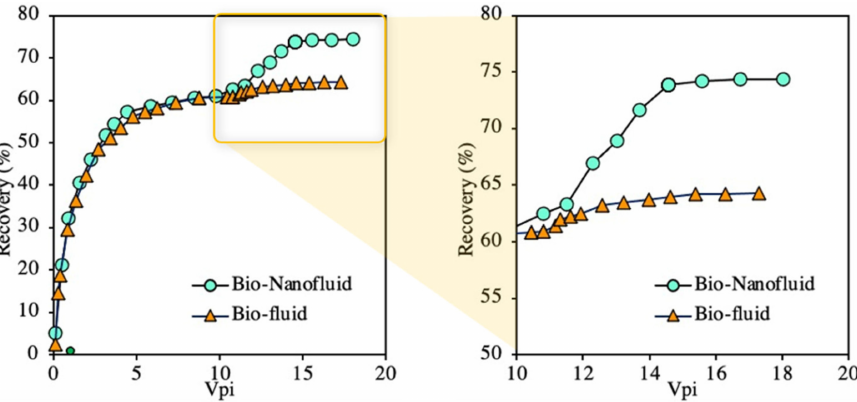
Figure 15. Recovery factor of displacement test at low pressure of bio-fluid and bio-nanofluid system at a dosage of 1000 mg · L − 1 . Setup performed at room conditions.